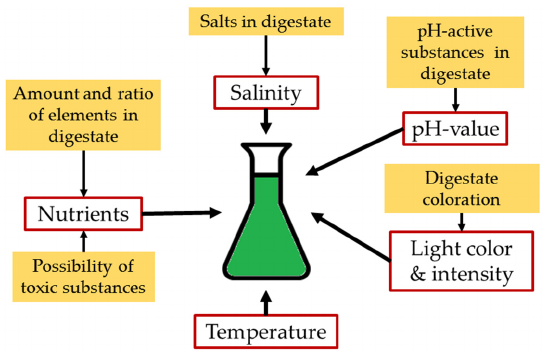
Figure 2. Overview of important variables for microalgae cultivation and the possible influences of digestate as nutrient source.